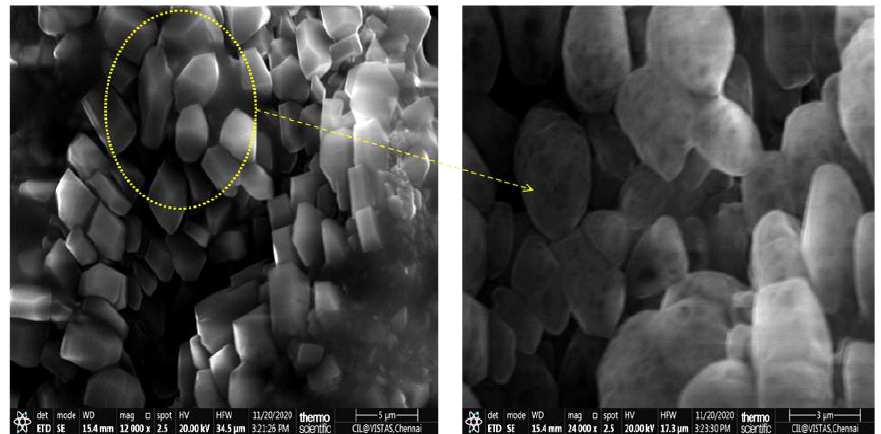
Figure 4. SEM analysis of chemically extracted chitin. Table 1. Energy-dispersive X-ray spectroscopy of chitin.